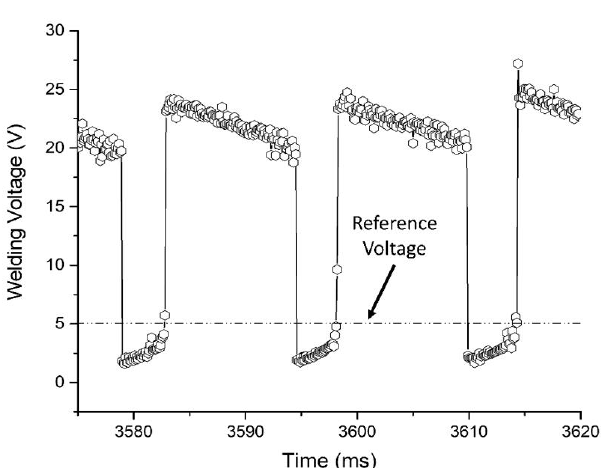
Figure 3. Schematic representation of the definition of the metal transfer period ( T ), short-circuit time ( tcc ), and reference voltage. Adapted from the work in [36].